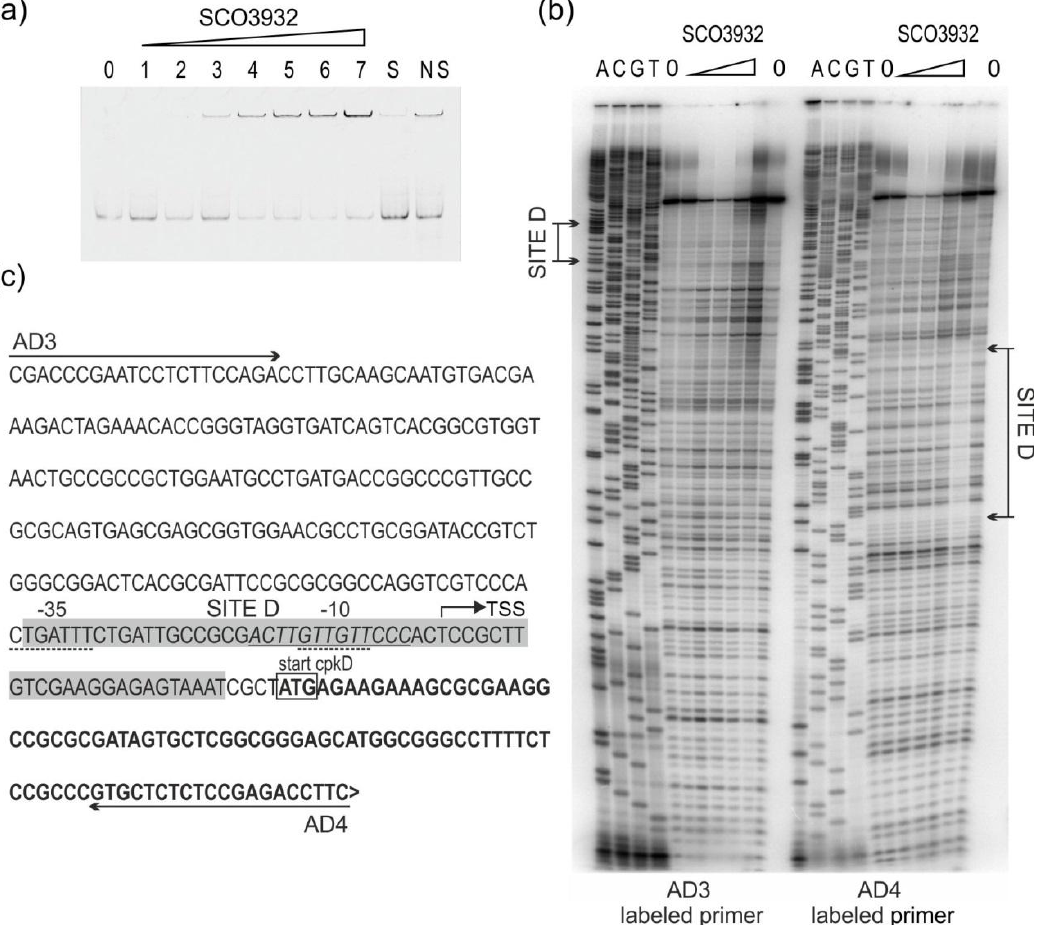
Figure 2. Binding of SCO3932 protein to the intergenic region between cpkA and cpkD genes. ( a ) Electrophoretic mobility shift assay with pcpkA/D fragment. Lanes 0–7 contain 0, 0.9, 1.8, 9.4, 18, 28, 47 and 94 nM SCO3932 protein, respectively. Lane S—ten-fold excess of the specific competitor DNA, lane NS ten-fold excess of nonspecific competitor DNA, respectively, and 94 nM SCO3932 protein; ( b ) DNase I footprinting of SCO3932 binding to the pcpkD promoter region. The amounts of SCO3932 used in the footprint were 0, 100, 200, 400, 800 1600, 0 nM. The region protected from cleavage by DNase I is indicated (site D). Lanes G, A, T, C correspond to the sequence ladder generated with the labelled primer. ( c ) DNA sequence of the cpkD promoter region. Primers are marked with horizontal arrows. Coding sequence is bold, translational start codon is marked with a box. Bent arrow denotes transcriptional start site (TSS) according to Jeong et al., 2016 [25]. The − 35 and − 10 regions are underlined with a dashed line. The sequence protected by SCO3932 from cleavage (site D) is indicated by the shaded box. Sequence corresponding to the common motif identified by MEME (see Figure 4) is underlined and in italic.